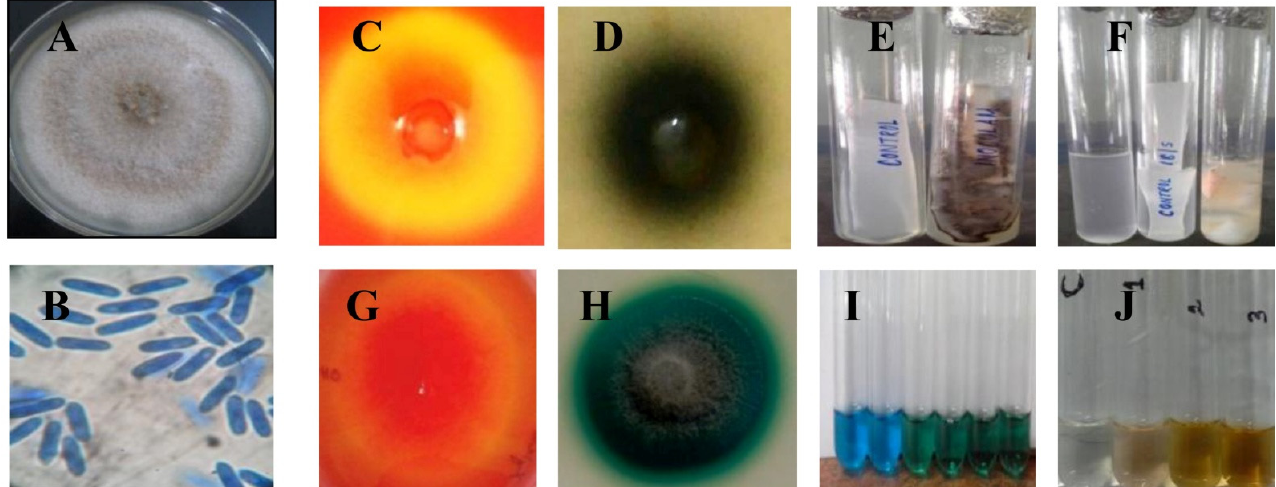
Figure 1. Screening for the lignocellulolytic potential of the strain OH. ( A ). Colony morphology of OH on PDA plate after 7 days at 30 °C; ( B ) microscopic appearance at magnification 100×; after 7 days at 30 °C; and ( C – J ) lignocellulolytic enzyme profile of OH. ( C ) Cellulose hydrolysis on CMC agar on the 3rd day of screening; ( D ) BGL plate screening using esculin as a substrate; ( E , F ) cellulose-degrading capabilities in minimal medium containing Whatman filter paper strip. Images after 7 days incubation. ( E ) Left tube: control without inoculum in solid media and ( F ) in liquid culture. ( G ) Screening for xylanase on a xylan agar plate. ( H ) Laccase activity was tested in an MSM containing ABTS (2-2 ′ -azino-bis (3-ethylbenzo- thiazoline-6-sulphonic acid). ( I ) Lignin peroxidase assay with methylene blue, left tube (1st tube): control without culture supernatant and ( J ) manganese peroxidase assay with methyl catechol, left tube (1st tube): control without culture super- natant.